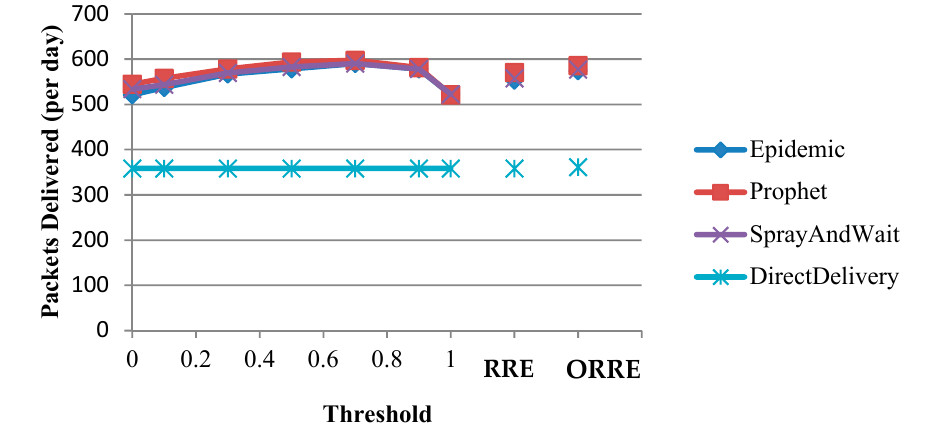
Figure 5. Packets delivered per day for Threshold, RRE and ORRE strategies in pigeon scenario.